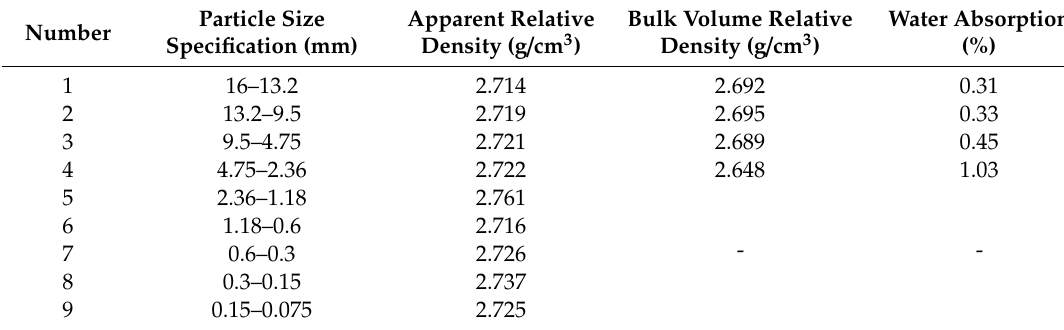
Table 4. Test results of aggregate density.